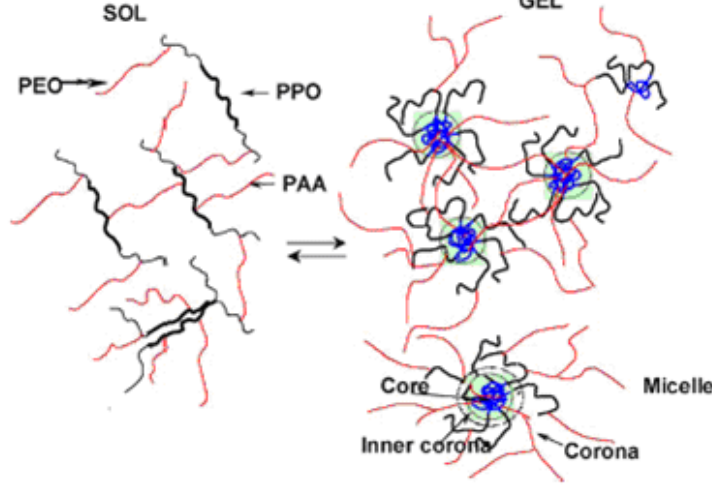
Figure 7. Scheme of the sol-gel transitions in Pluronic-PAA aqueous solutions [109].